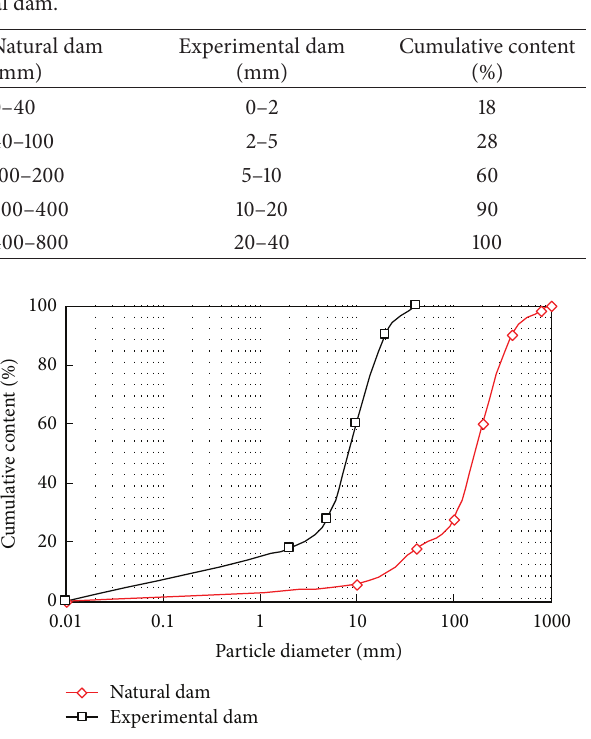
Figure 4: Particle size distribution comparison of the natural dam and the experimental